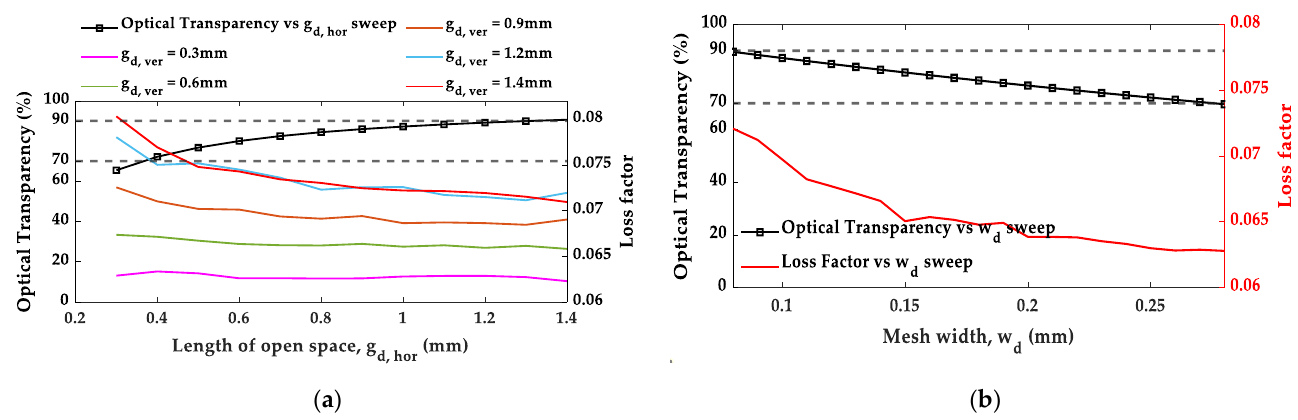
Figure 6. Effect of diamond mesh on loss factor: ( a ) length of the open space, 𝑔 𝑑,ℎ𝑜𝑟 , 𝑔 𝑑,𝑣𝑒𝑟 ; ( b ) mesh width, 𝑤 𝑑 .